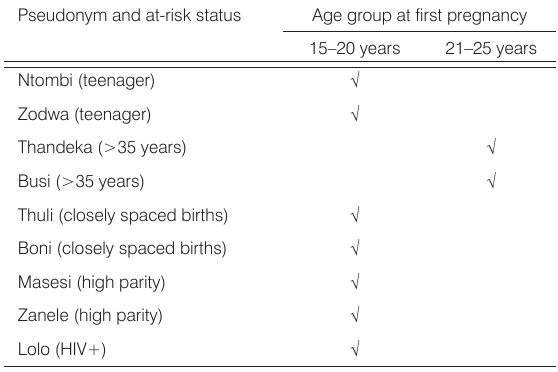
Table 1. Women at risk by age at first pregnancy ( N =